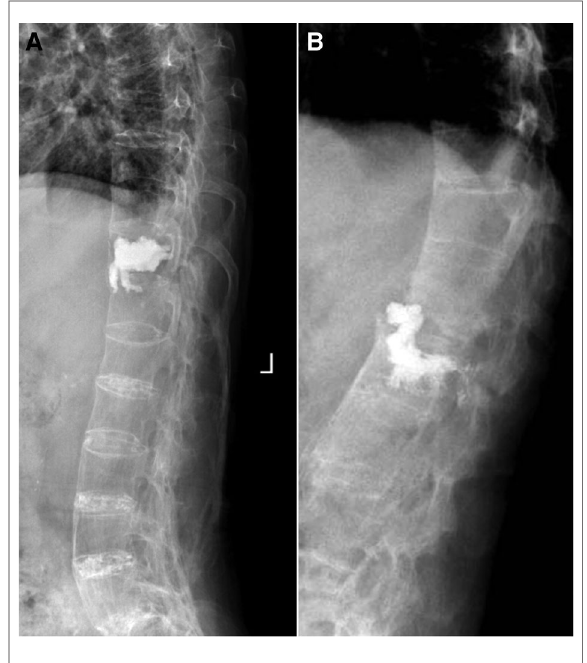
FIGURE 5 Asymptomatic intradiscal polymethylmethacrylate cement leakage was found in two patients by postoperative x-ray. The cement respectively leaked into the lower ( A ) and upper ( B ) discs of the fractured